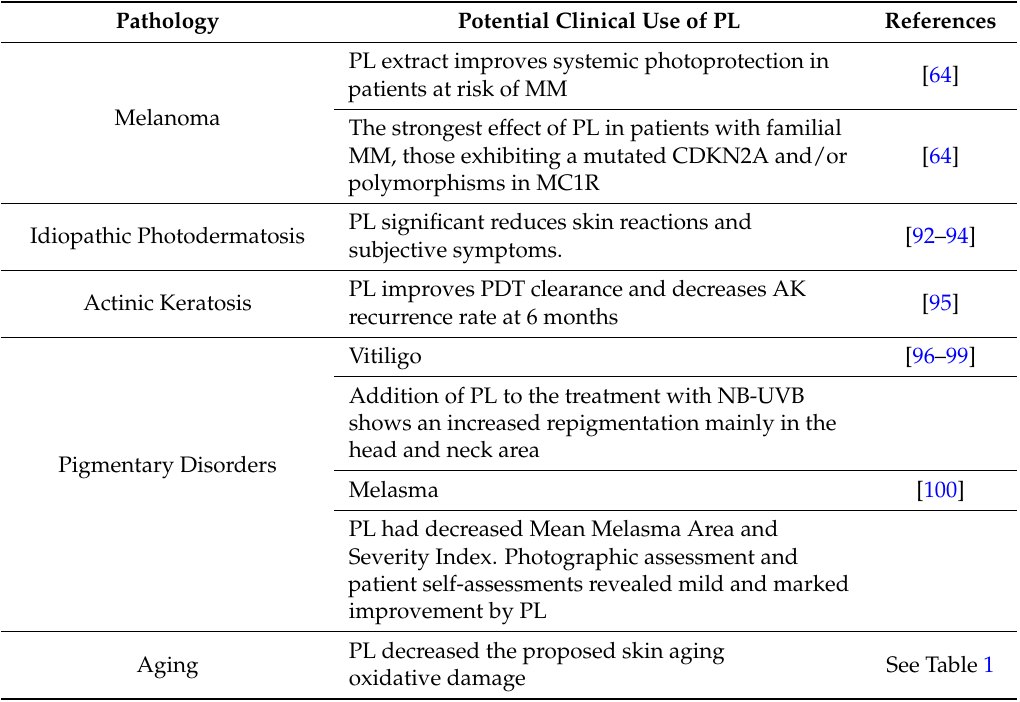
Table 2. Application of Polypodium leucotomos (PL) in the treatment of skin